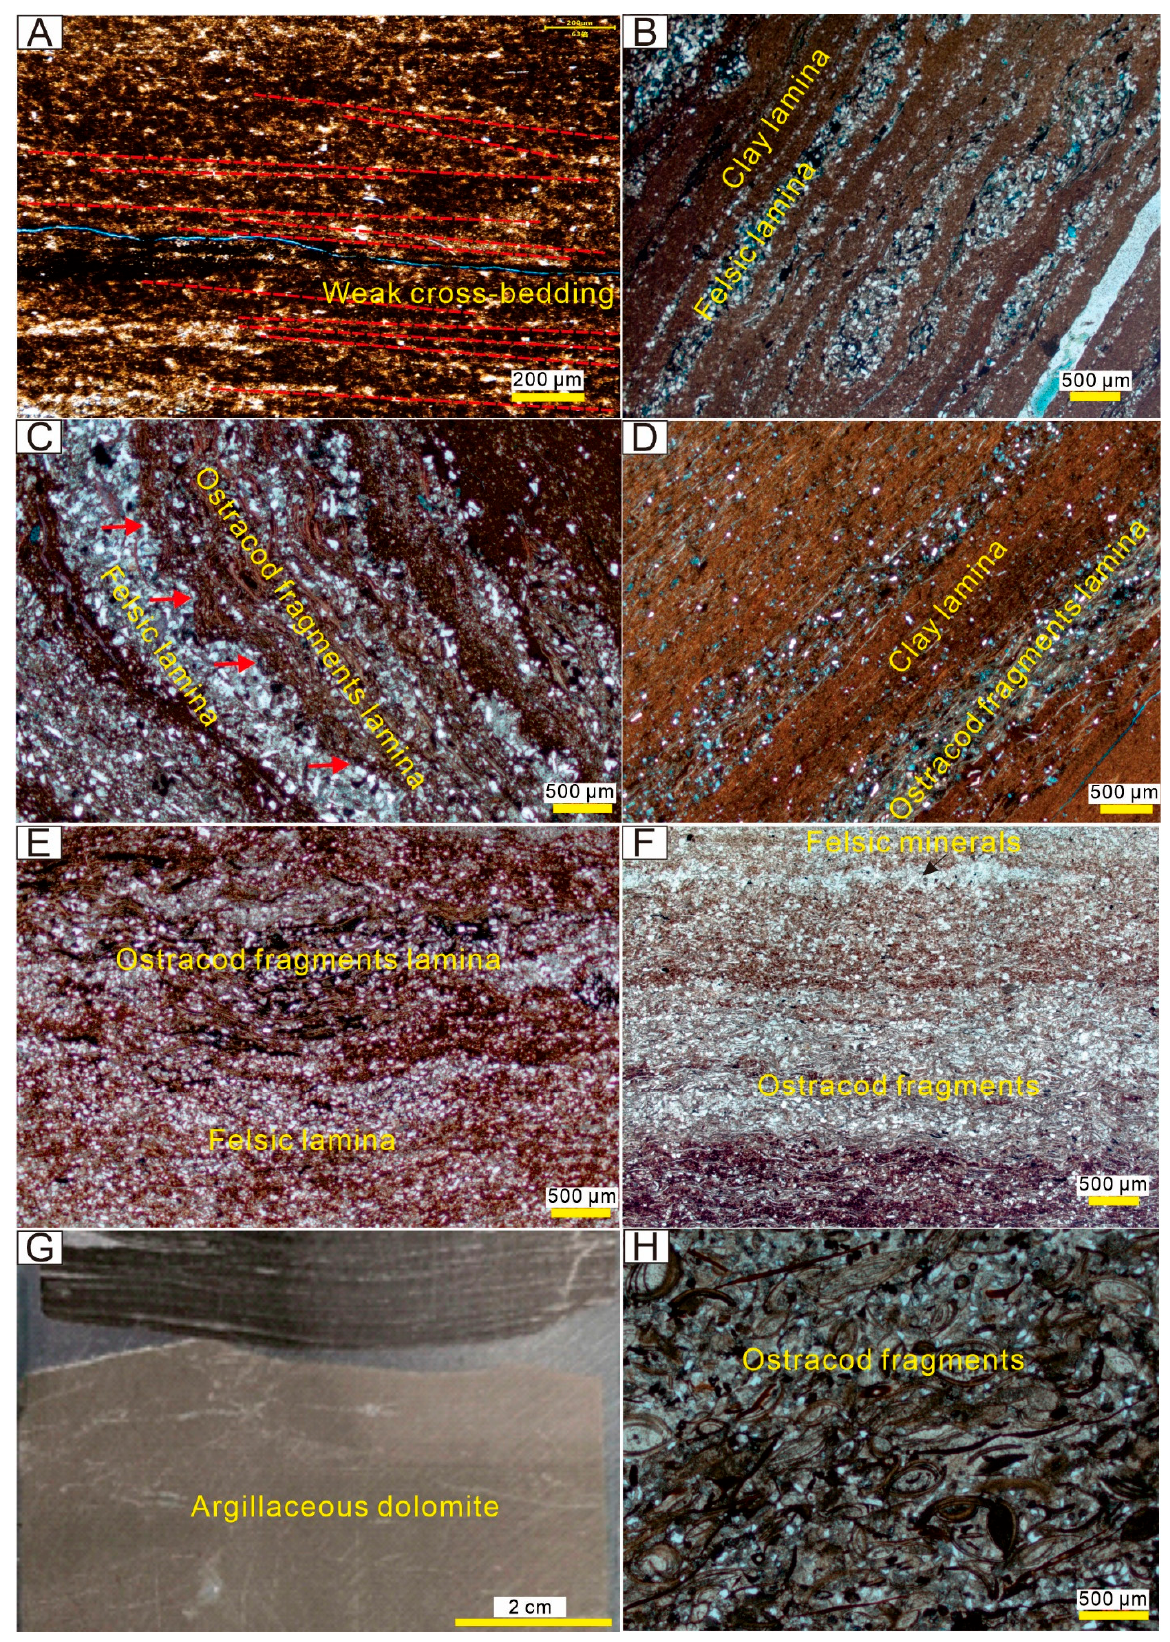
Figure 6. Sedimentary structures of FGSRs of the Qingshankou Formation. (Abbreviations: CPL = cross ‐ polarized light; PPL = plane ‐ polarized light). ( A ) Laminated structure, composed of felsic